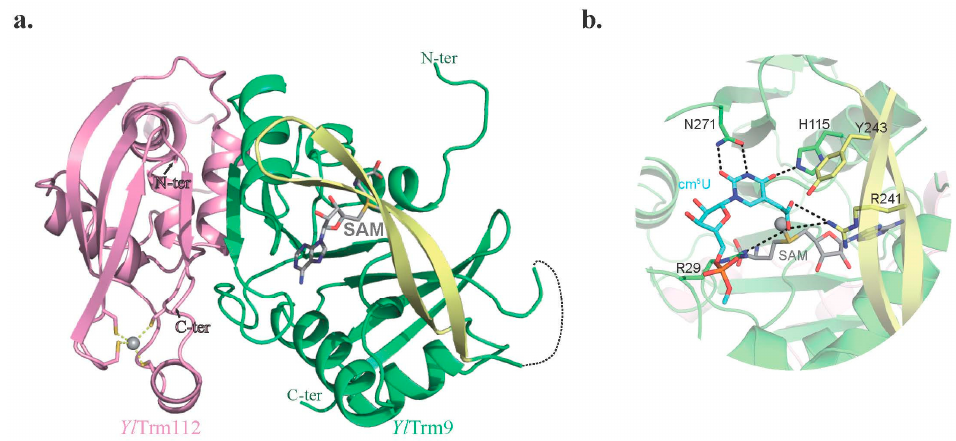
Crystal structure of the Yarrowia lipolytica ( Yl ) Trm9-Trm112 complex. ( a ) Ribbon representation of the Yl Trm9-Trm112 complex. The S -adenosyl- L -methionine (SAM) molecule (grey sticks), which was absent in the crystal structure, has been modeled by superimposing the SAM-bound structure of Bud23 onto Yl Trm9. The Trm9 lid is colored yellow. ( b ) Model of cm 5 U 34 (blue sticks) docked into the Yl Trm9 active site. The SAM methyl group to be transferred is depicted as a sphere. Residues are numbered according to the S. cerevisiae protein.